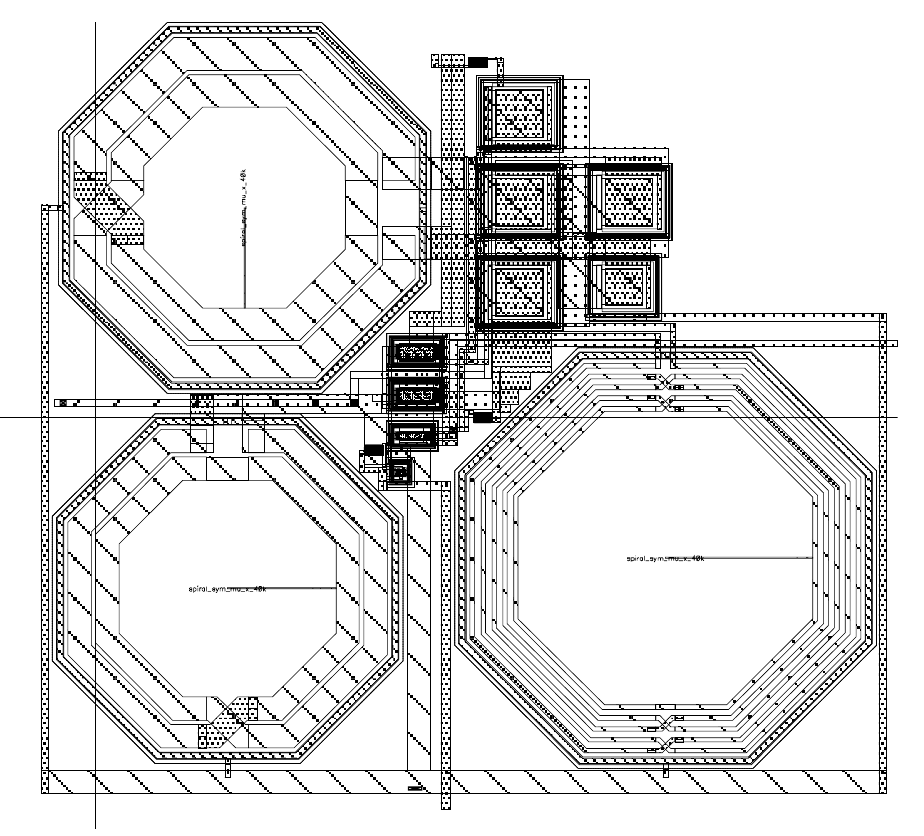
Figure 12. The layout of the designed LNA with the area of 500 µ m × 530 µ m. The transistor dimension (located at the center of the layout) is 17 µ m × 19 µ m which is less than 0.2% of the total area of the LNA. The top left is the drain inductor L D , and the source inductor L S is at the bottom left. The gate inductor L G is located at the bottom right. The drain load capacitor C D , the input and output capacitors C in and C out and the AC coupling C buf fer are shown on the upper right corner. Our simulation results